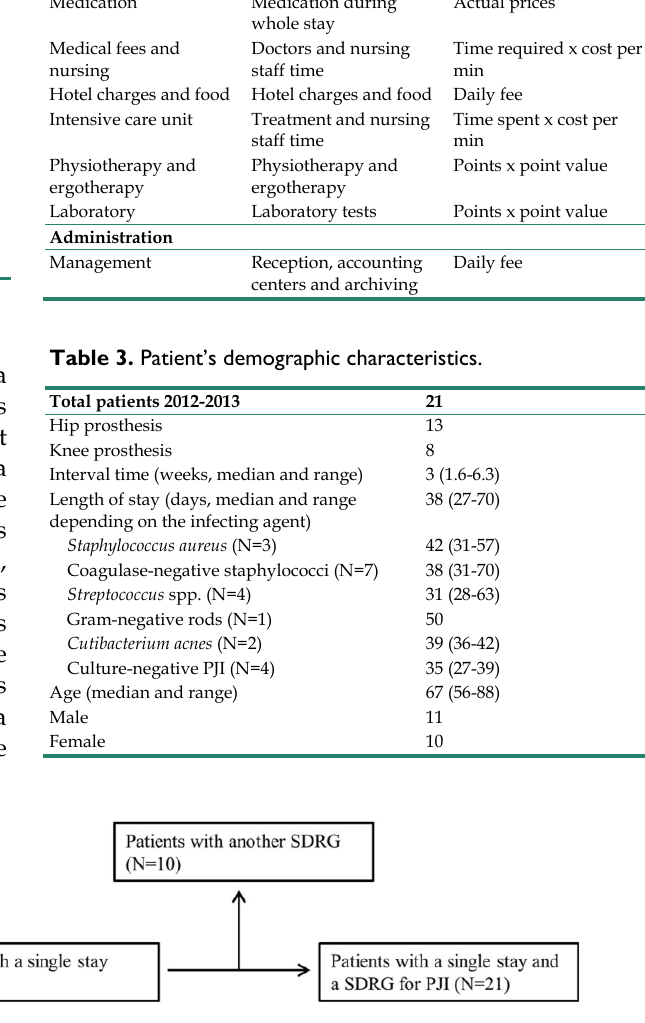
Figure 3. Flow of the patients